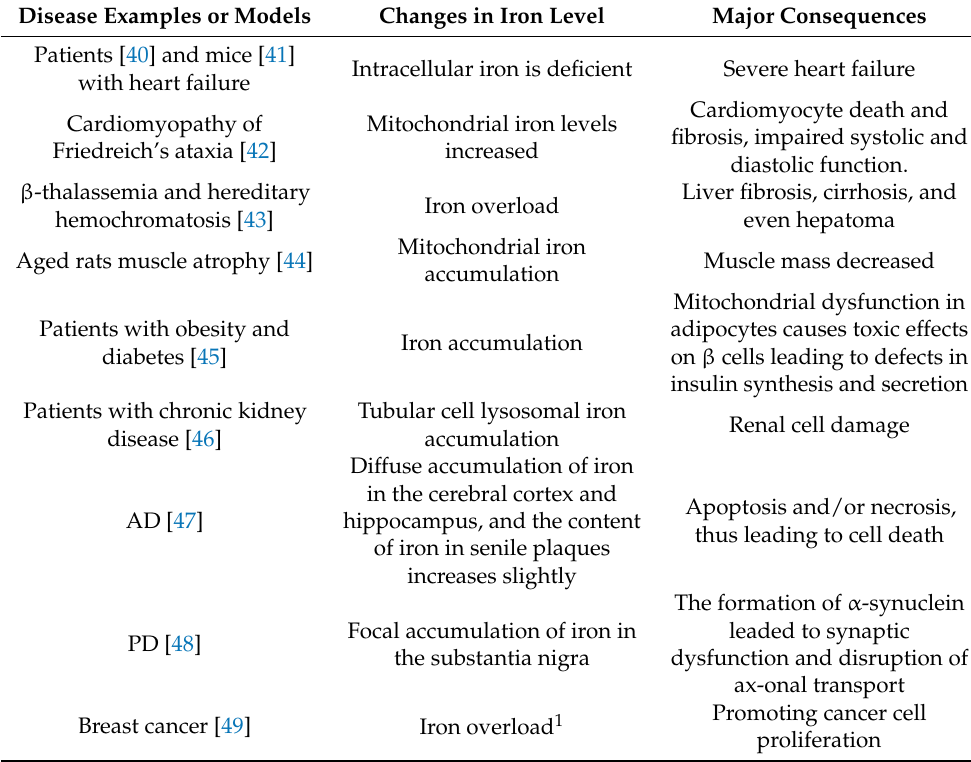
Table 1. Classification of diseases based on major consequences of changes in iron